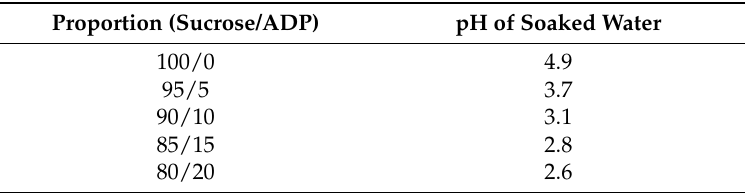
Table 3. pH of the solution after water-immersion treatment at 20 °C for 24 h.